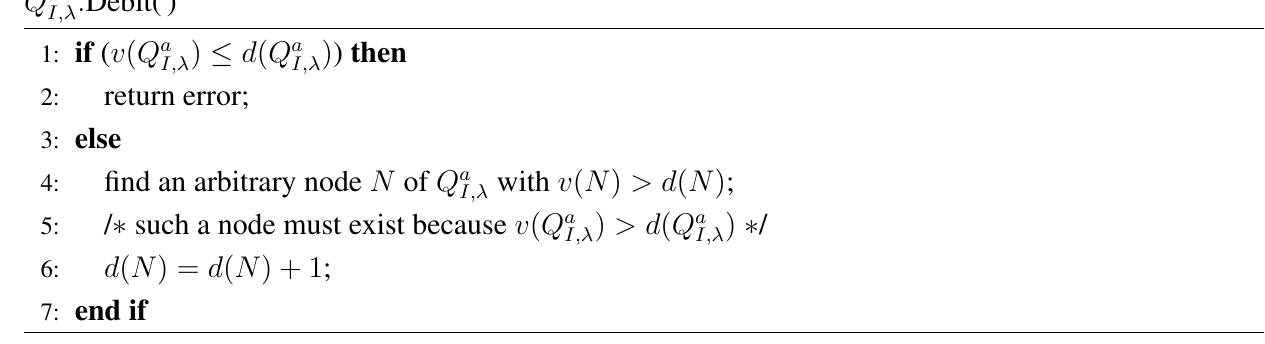
before the arrivals of items I,λ